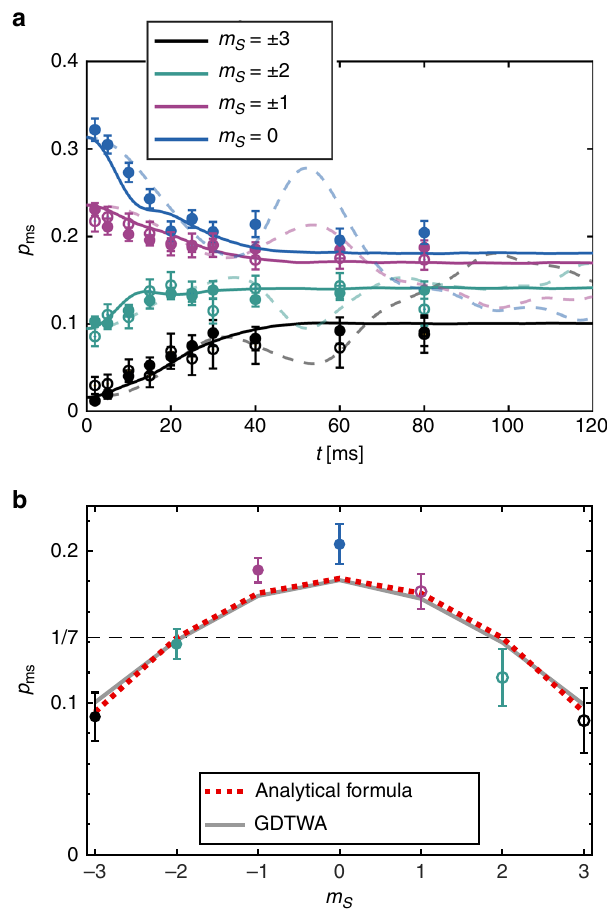
Fig. 3 Quantum thermalization. a Long-time evolution of state populations for θ = π /2: Long-time experimental data points are compared with corresponding best fi tting GDTWA (solid lines, B Q ≈ − 3.6 Hz) and mean- fi eld (thin dashed lines, B ≈ 1.1 Hz) simulations. b The experimental data Q points at t = 80 ms are compared with the GDTWA prediction (including fi eld gradients), and the analytical quantum thermalization expression, Eq. (6), which corresponds to an effective temperature of − 2.5 nK, using B = − 3.6 Hz. Error bars correspond to statistical standard Q